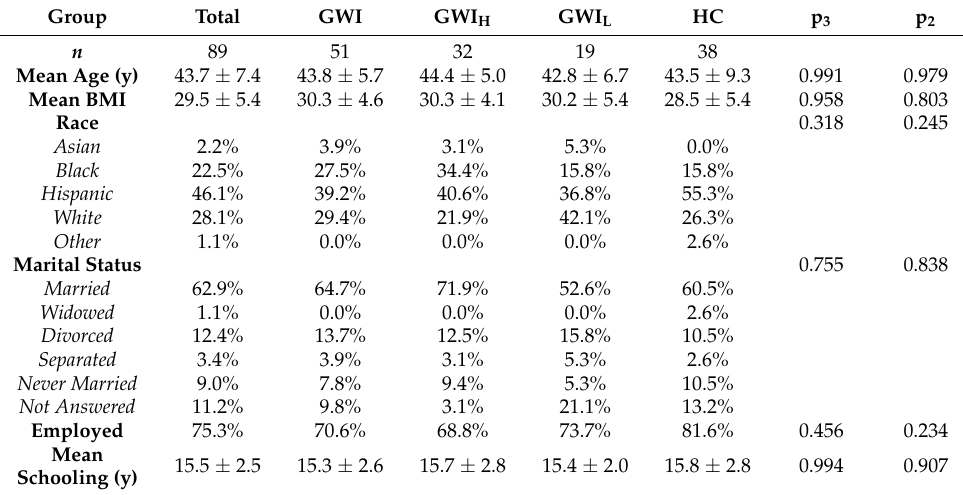
Table 1. GWI cohort